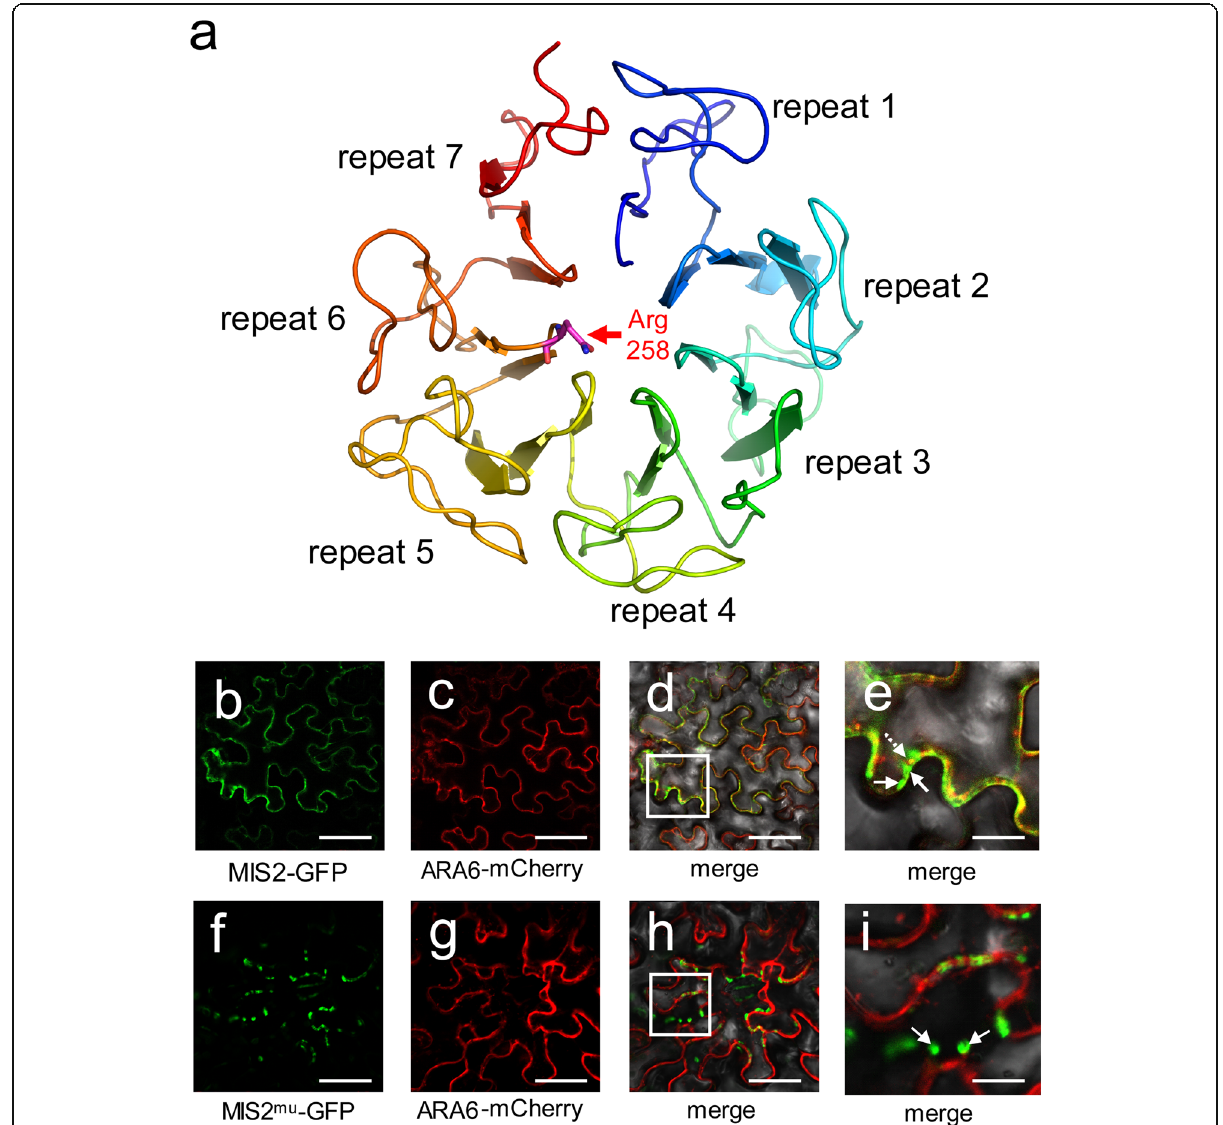
Fig. 7 Subcellular behavior of MIS and MIS2 mu protein. ( a ) Three-dimensional model of the MIS2 extracellular repeat domain using PyMol. Seven repeats are labeled and Arg 258, which is mutated to Gln in mis2 , is shown as a stick and colored purple. ( b - e ) Co-expression of MIS2 and ARA6 in tobacco leaf. The florescence of MIS2::GFP ( b) and ARA6::mCherry ( c ) were detected and merged on the plasma membrane ( d ). The merged image ( e ) is a magnification view of the boxed region in ( d ). Line arrows indicate GFP-only vesicles, and dot arrows indicate co-localizations. Bar = 20 μ m ( b - d ), Bar = 10 μ m ( e ). ( f - i ) Co-expression of MIS2 mu and ARA6 in tobacco leaf epidermal cells. ARA6::mCherry is localized on plasma membrane ( g ). MIS2 mu ::GFP localization is considerably changed ( f , h ). Magnification view shows GFP-labeled and mCherry-labeled compartments in cytoplasm and no colocalization is observed (I). Line arrows indicate GFP-only vesicles, respectively. Bar = 20 μ m ( f - h ), Bar = 10 μ m ( i